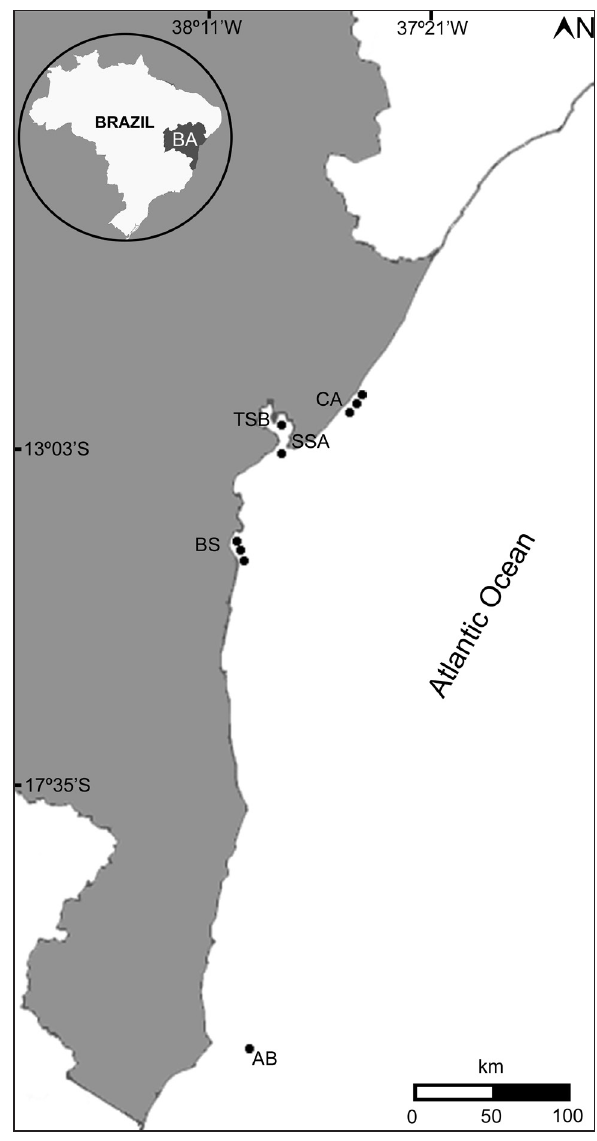
Figure 1. Distribution map of Cellaria oraneae sp. nov. in state of Bahia, northeast Brazil. (BA) Bahia, (CA) Camaçari, (SSA) Salvador, (TSB) Todos os Santos Bay, (BS) Baixo Sul, (AB) Abrolhos ZOOLOGIA 35: e24571 | DOI: 10.3897/zoologia.35.e24571 | March 9, 20182 /